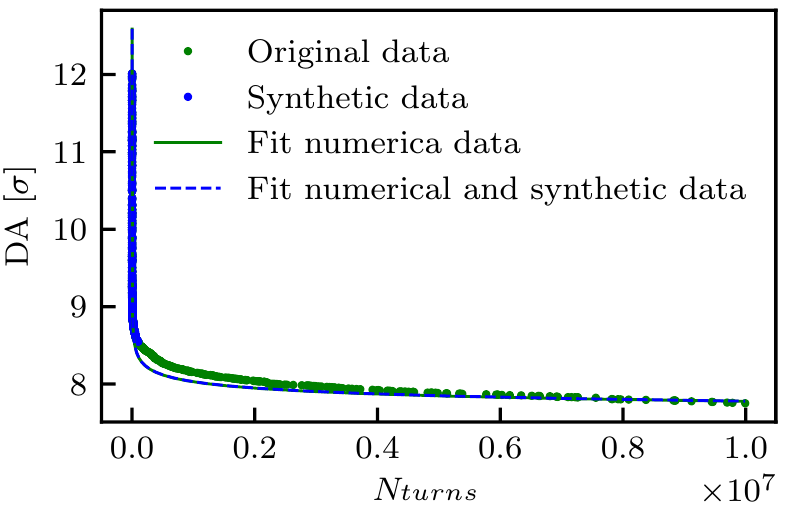
Figure 8. Example of fits of the DA model (14b) with three free parameters, based on a set of data from numerical simulations. The approach based on the use of synthetic points generated by GP is also shown. Note that the original fit and that based on GP overlap almost